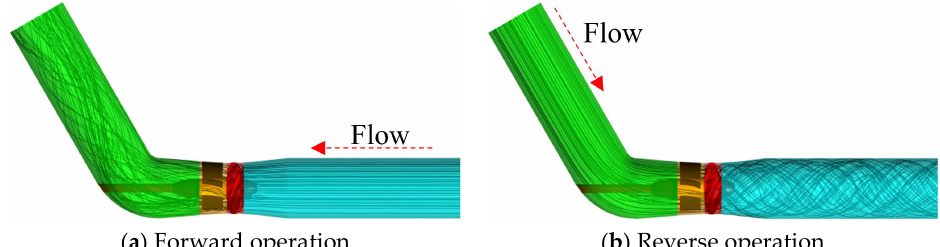
Figure 9. Uniformity of flow velocity at impeller inlet.